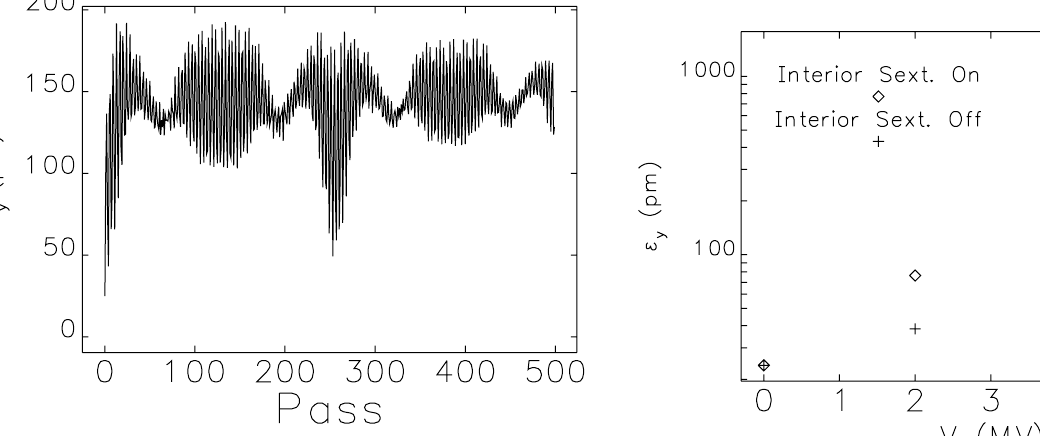
effects.FIG. 8. Vertical emittance on successive passes in the ring, with 6 MV and h (cid:3) 8 , showing the partial recovery of the emittance after a synchrotron oscillation (about 250 turns). Interior sextupoles and synchrotron radiation effects are